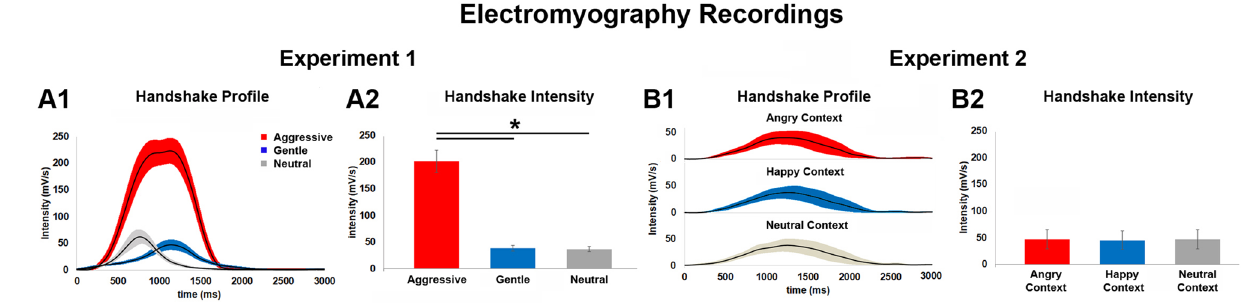
Figure 5. The graphs show the mean handshake profile (A1) and the mean intensity ( A2 ) of the aggressive, gentle, and neutral handshakes detected by EMG in Exp. 1. The horizontal lines above the bars indicate the comparisons among aggressive, gentle, and neutral handshakes ( A2 ). Asterisk indicates significant differences set at p ≤ 0.05 (*). The graphs show the mean handshake profile ( B1 ) and the mean intensity ( B2 ) of the neutral handshake detected by EMG in Exp. 2 during the observation of angry, happy and neutral facial expressions (Fig. 6C). Notably, these insular and cingulate sectors partially overlaps with those found in Exp. 1 involved in the processing of tactile vitality forms (Fig. 7). Region‑of‑interest analysis. The results of the GLM analysis carried out in Exp. 2 on the BOLD signal change extracted in the insular and cingulate cortices, indicated in both areas a significant difference of the BOLD signal among the happy, neutral and angry interpersonal contexts (insula: F = 4.2, p = 0.02; cingulum: F = 5.8, p = 0.01). Post hoc analysis revealed in both regions a significant difference between the angry and happy contexts and between the angry and neutral contexts (insula: angry > neutral, p = 0.03; angry > happy, p = 0.03; cingulum: angry > neutral, p = 0.02; angry > happy, p = 0.01; Newman–Keuls correction; Fig. 6C).